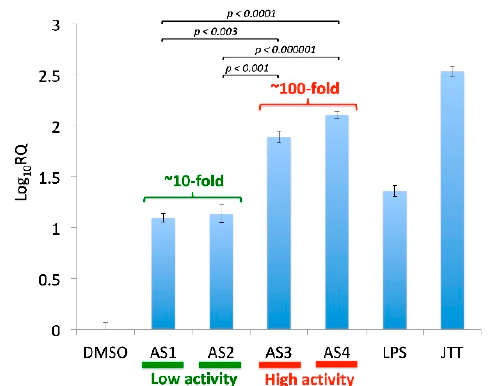
Figure 1. Immunostimulatory activity of four Angelica sinensis samples. The activity was measured by qRT-PCR of ICAM-1 in THP-1 monocytes. Cells were treated with samples for four hours; JTT (Juzen-taiho-to, 100 µ g / mL, positive control); lipopolysaccharide (LPS) ( Escherichia coli LPS, 0.1 ng / mL, positive control), A. sinensis samples (5 µ g / mL); DMSO (vehicle control). Each sample was analyzed at least in triplicate ( n = 3). RQ (Relative Quantitation): fold change. AS3 and AS4 showed much higher activities (77-fold and 128-fold, respectively) than AS1 and AS2 (both ~12-fold).